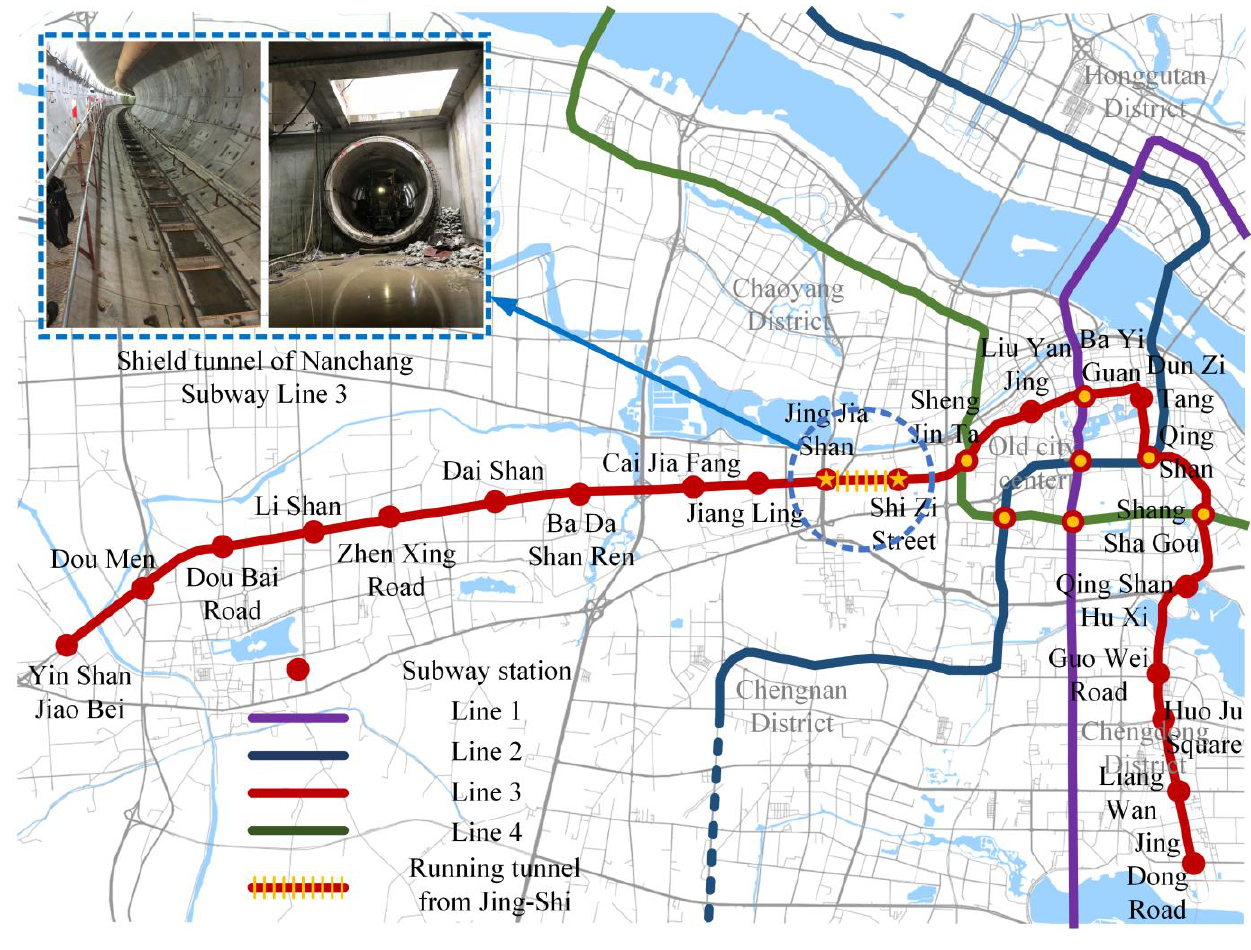
Appl. Sci. 2022 , 12 , x FOR PEER REVIEW Figure 5. A plan view of Nanchang Subway. Figure 5. A plan view of Nanchang Subway.